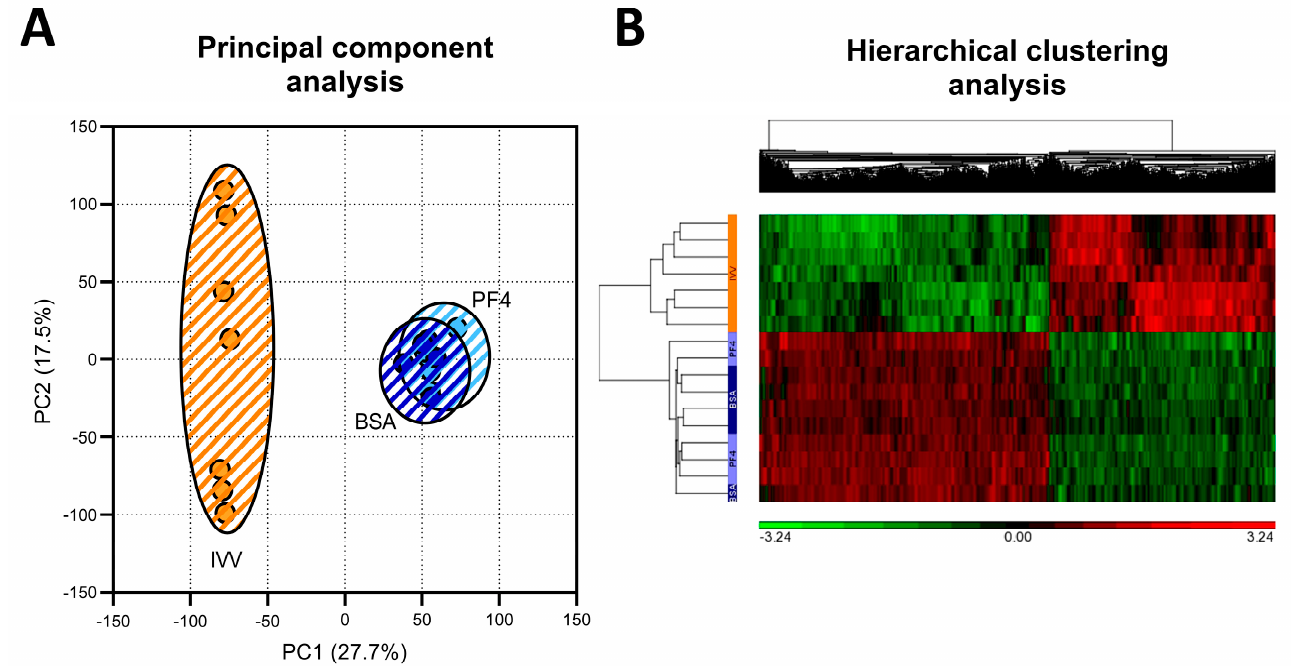
Figure 2. Distribution of the analyzed samples according to unsupervised analysis. ( A ) Principal component analysis obtained from the microarray results. ( B ) Hierarchical clustering analysis comparing the differentially expressed genes (|FC|</>1.5 and adjusted p value < 0.05) for the three experimental groups.